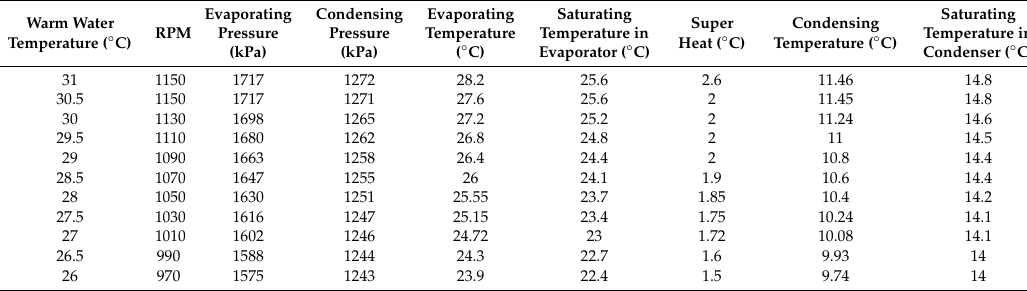
Table 3. Operating fluid pump RPM control range according to the surface water temperature (cold water temperature: 6.5 ◦